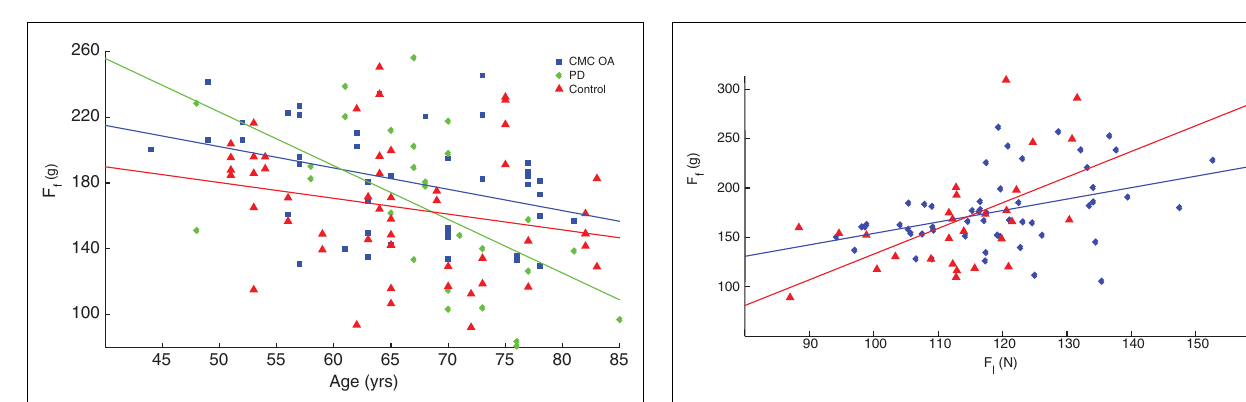
FIGURE 8 | Correlation of finger and leg dexterity . Both male (blue circles) and female (red triangles) participants showed significant association between finger and leg compression force in the self-reported dominant limb, with females exhibiting higher correlation than males, ρ = 0.529 and 0.403,